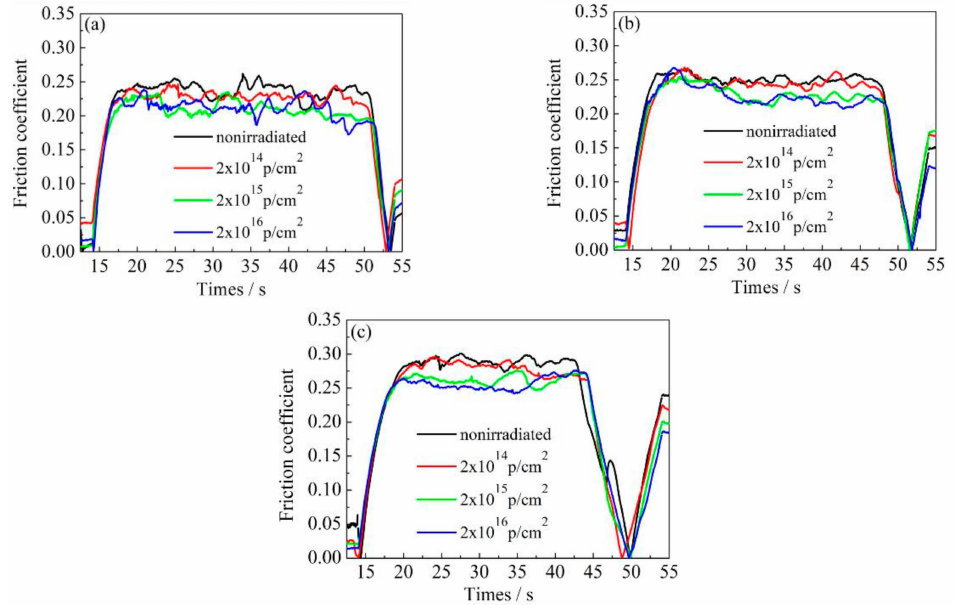
Figure 8. Friction coe ffi cient variations of 600 ◦ C-tempered AISI 420 steels after proton radiation with di ff erent cumulative charges. ( a ) 2000 µ N; ( b ) 3000 µ N; ( c ) 4000 µ